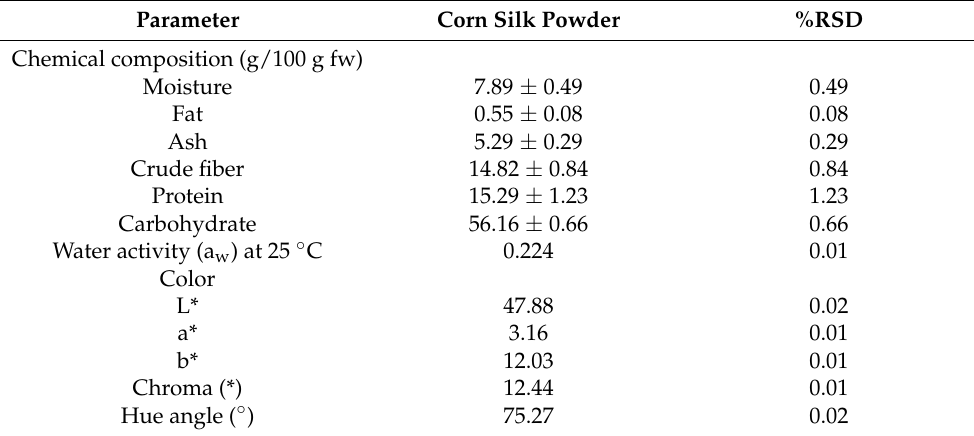
Table 1. Chemical analysis of corn silk